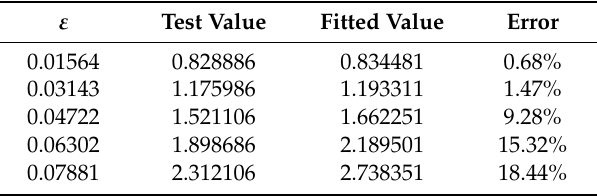
Table 18. The deviation between the test and calculated values for specimen 3 under 400 ◦ C. ε